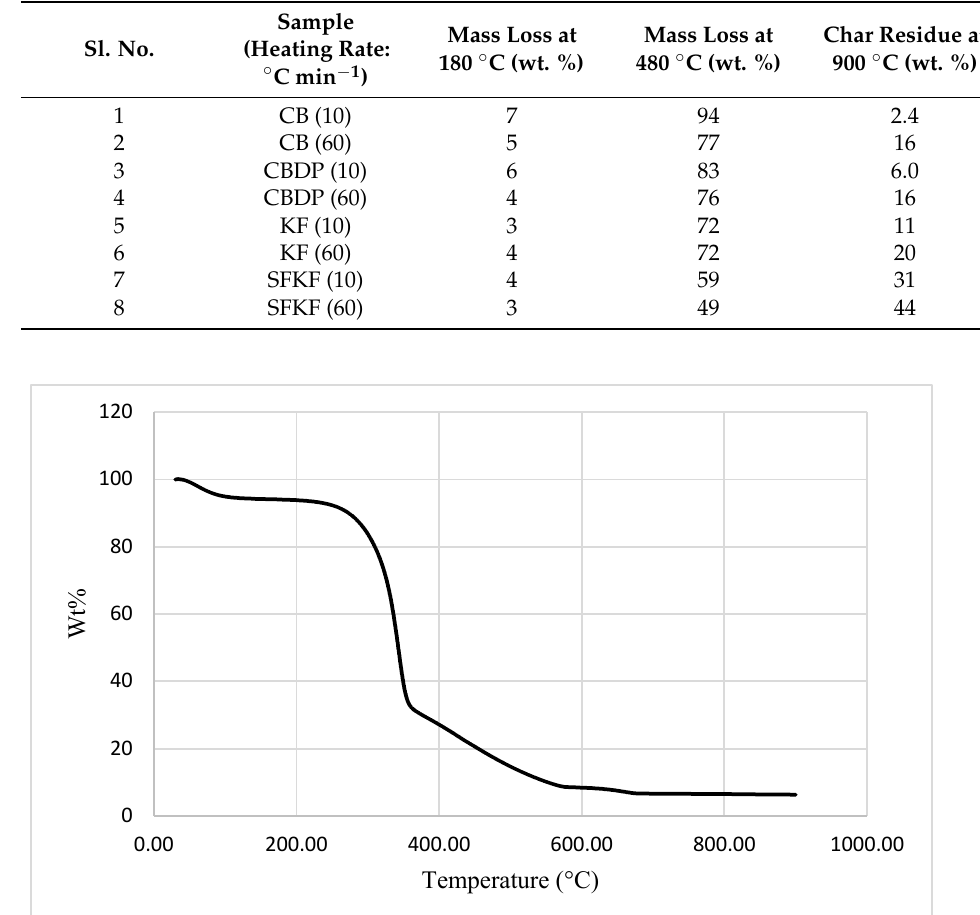
Figure 3. Thermogram obtained for CB sample at a heating rate of 10 °C min − 1 in nitrogen .